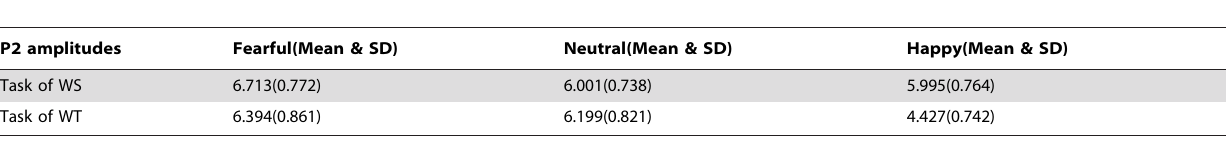
Table 5. Means and standard deviations of P2 mean amplitudes ( m V) in the time window of 154–190 ms at electrode FZ in Experiment 2 for the word structure and word tone judgment tasks when fearful, neutral and happy faces were unattended